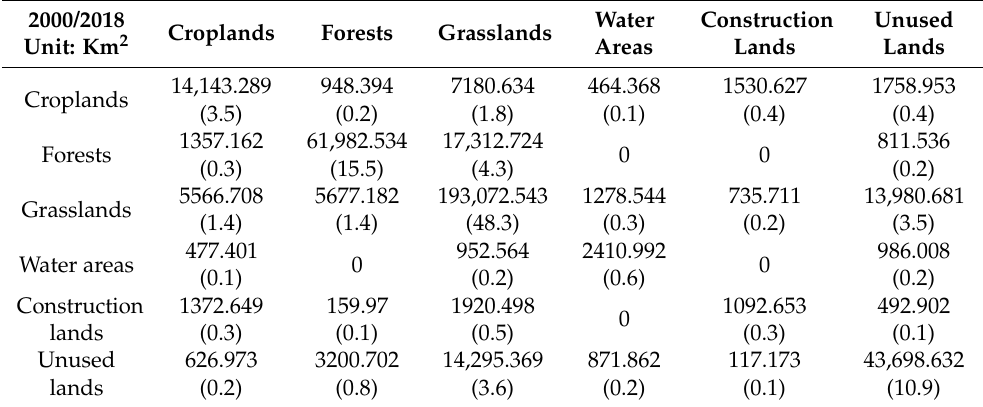
Table 6. The area of specific land use conversion in 800~1300